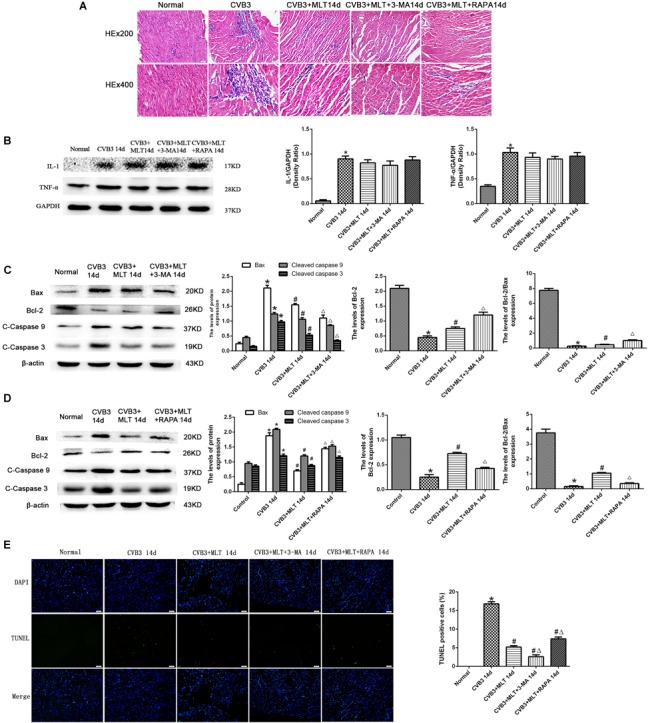
The effects of melatonin on inflammation and apoptosis on day 14. (A) Representative myocardial pathological changes on day 14 (n = 5 in each group, three sections per heart were examined). (B–D) Expression of proinflammatory cytokines, apoptosis-related protein Bax, Bcl-2, cleaved caspase-3, and cleaved caspase 9 in the heart on day 14 (n = 5 in each group). (E) Double staining for DAPI (blue) and TUNEL (green) of sections from myocardium on day 14, scale bar = 50 μm (n = 5 in each group). ∗P < 0.05 versus the normal group, #P < 0.05 versus the CVB3 group, ∆P < 0.05 versus the CVB3 + MLT group.